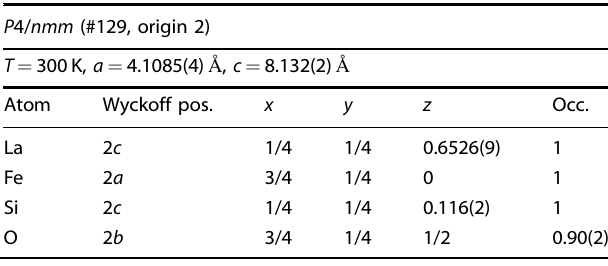
Table 1. LaFeSiO 1 − δ re fi ned crystal structure at 300 K from NPD data (Bragg R-factor = 5.05). P 4/ nmm (#129, origin 2)